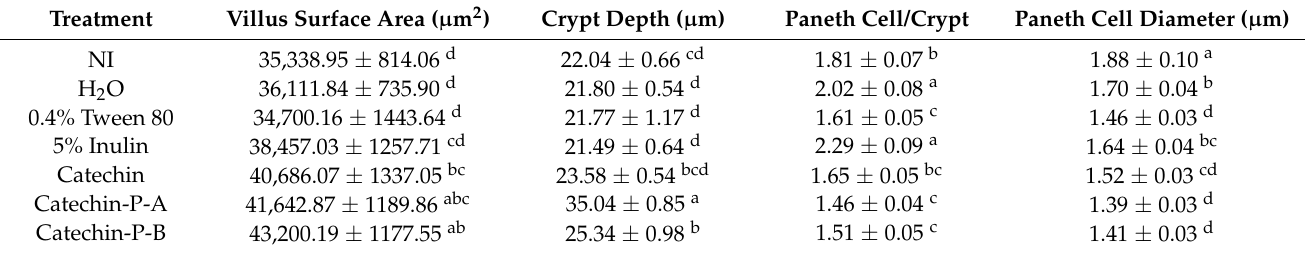
Table 3. Effect of the intra-amniotic administration of experimental solutions on the duodenal small intestinal villus, crypt depth, and Paneth cells 1